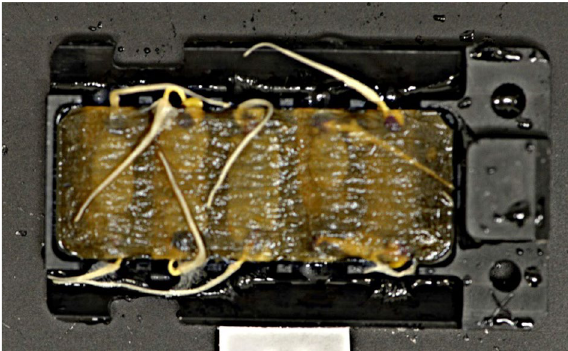
Figure 2. Example of root orientation inside seed cassettes. The predominant curvature and elongation occurred onto and along the surface of the germination